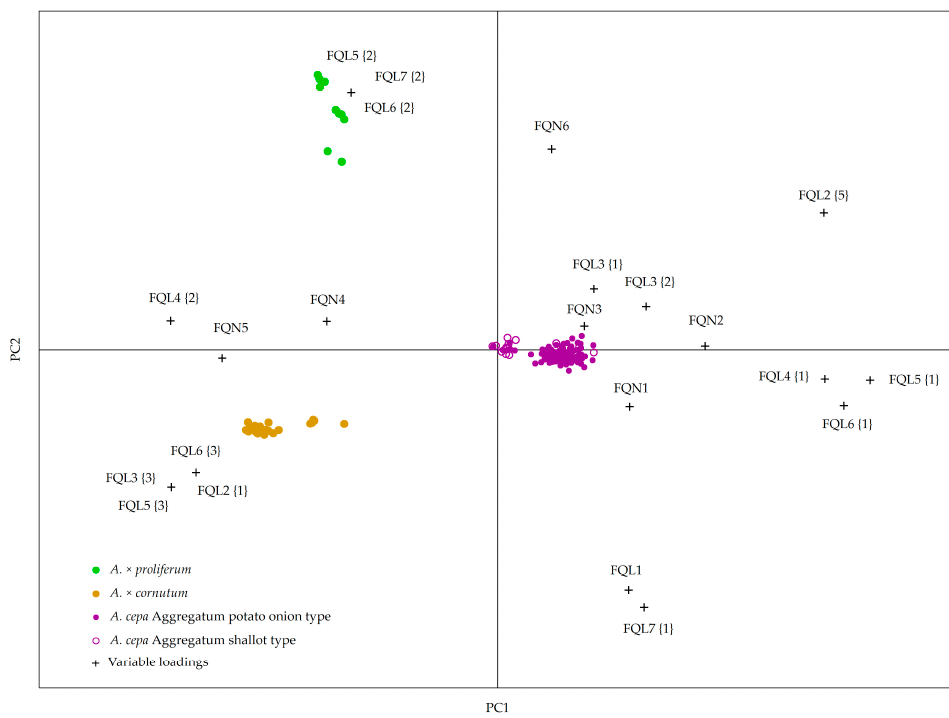
Figure 1. Principal Components Analysis (PCA) biplot based on generative descriptors for 32 flower- ing shallot accessions from Croatia. Five individual plants per accessions were measured; each dot in the biplot represents one individual